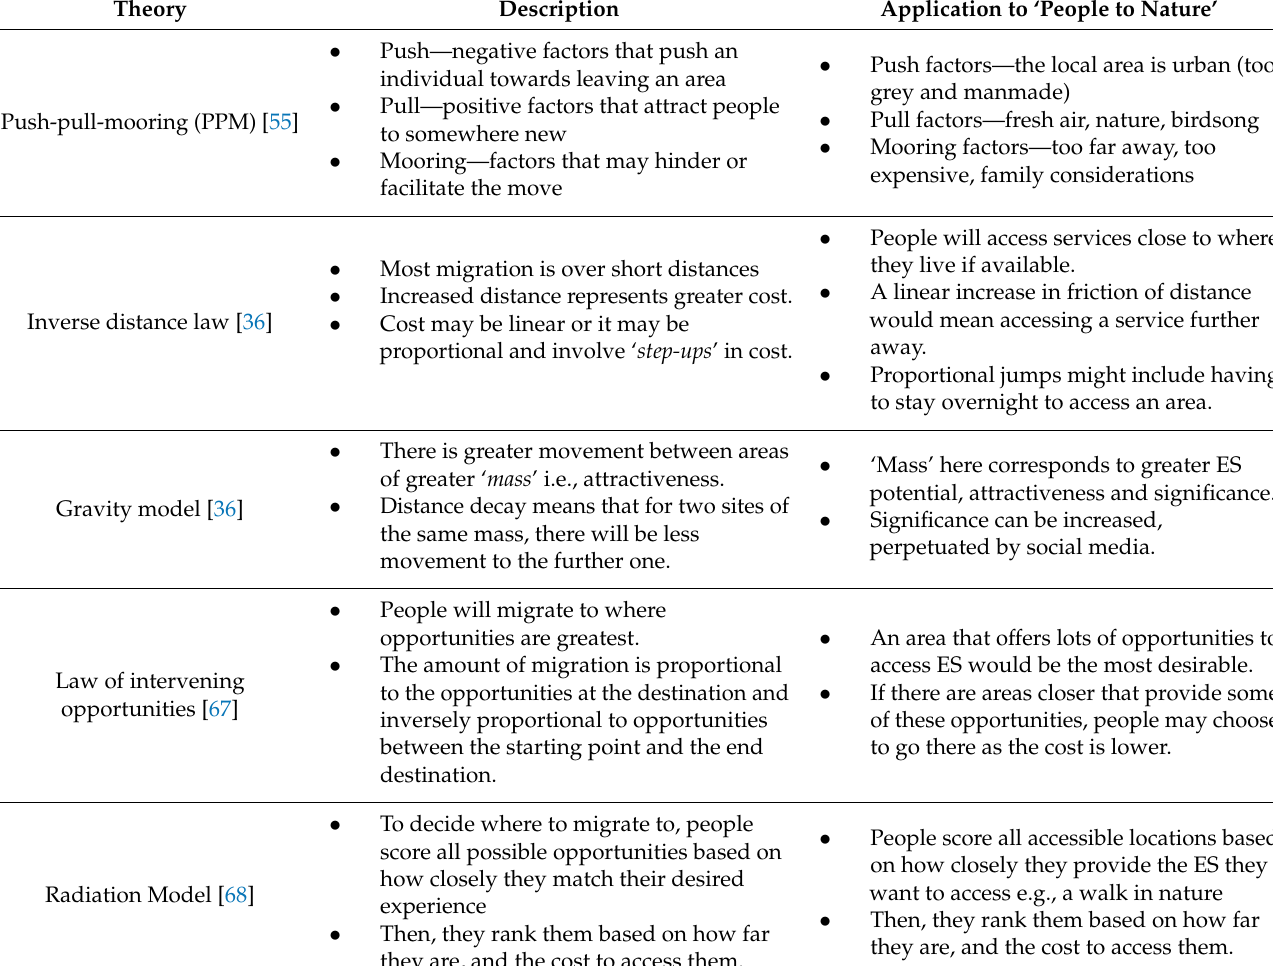
Table 2. Summary of migration theories and potential applications to ‘people to nature’ (the movement of beneficiaries to a transactor in search of an ecosystem service).